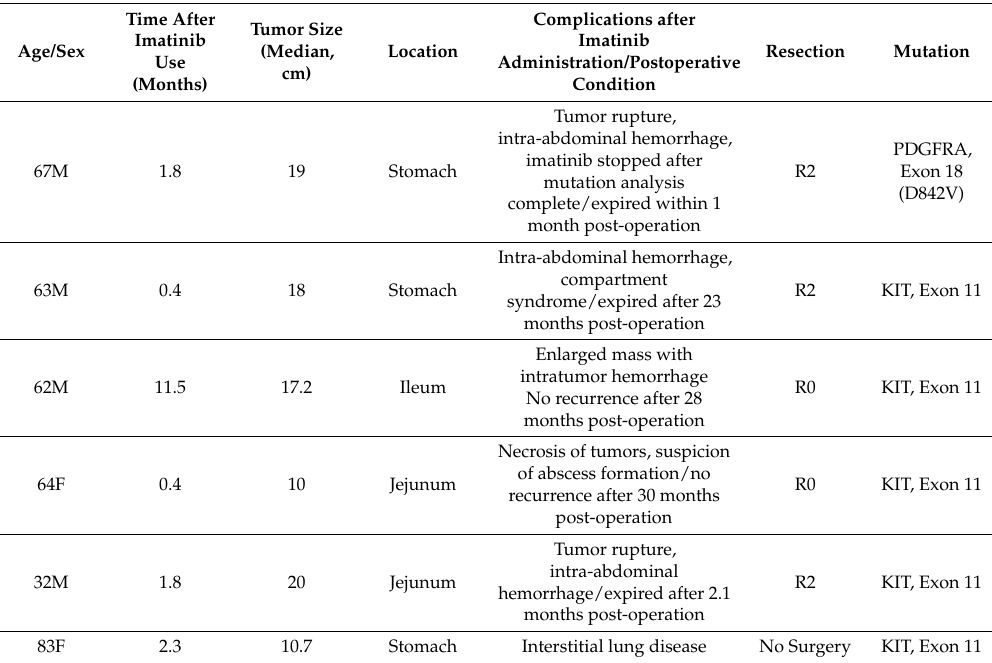
Table 2. Complications after neoadjuvant imatinib use ( n =